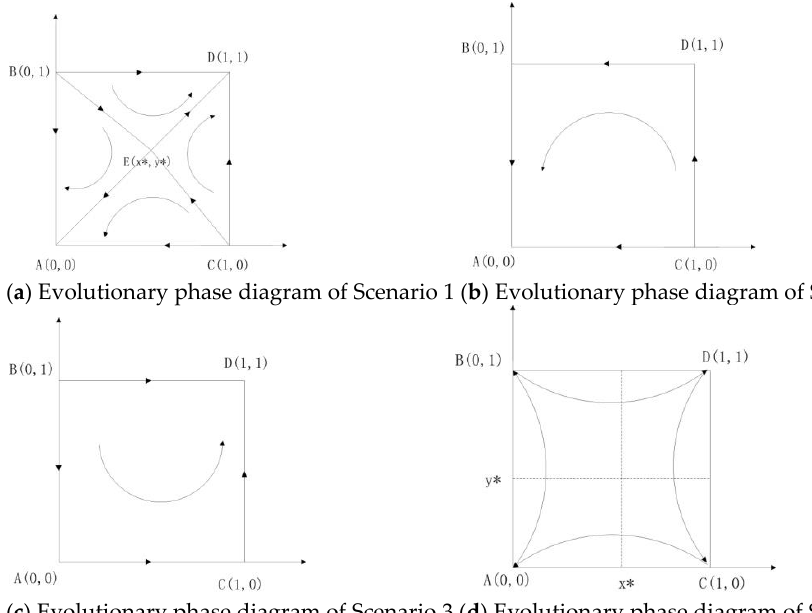
Figure 1. Evolutionary phase diagrams of Scenario 1 to 4.